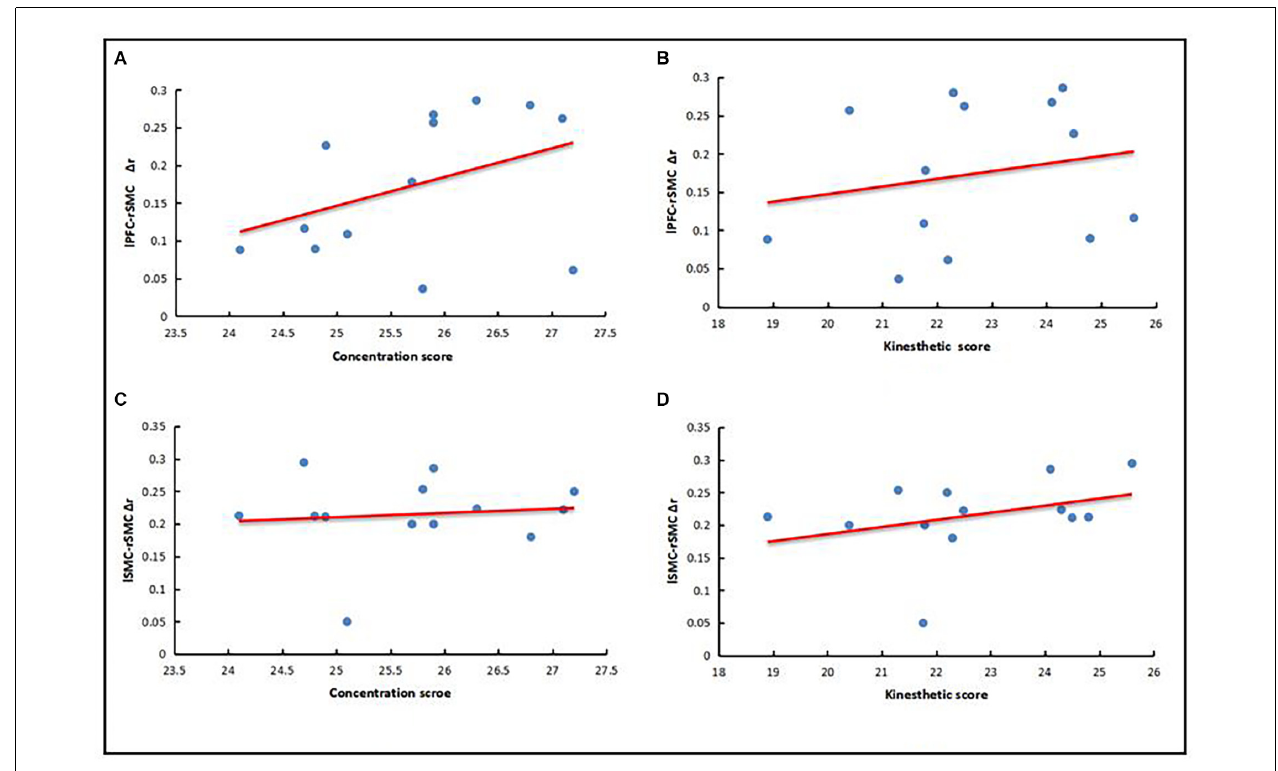
FIGURE 5 | Correlation between behavioral results and neural results. (A) LPFC-RSMC ( ∆ r) and concentration score. (B) LPFC-RSMC ( ∆ r) and kinesthetic perception score. (C) LSMC-RSMC ( ∆ r) and concentration score. (D) LSMC-RSMC ( ∆ r) and kinesthetic perception